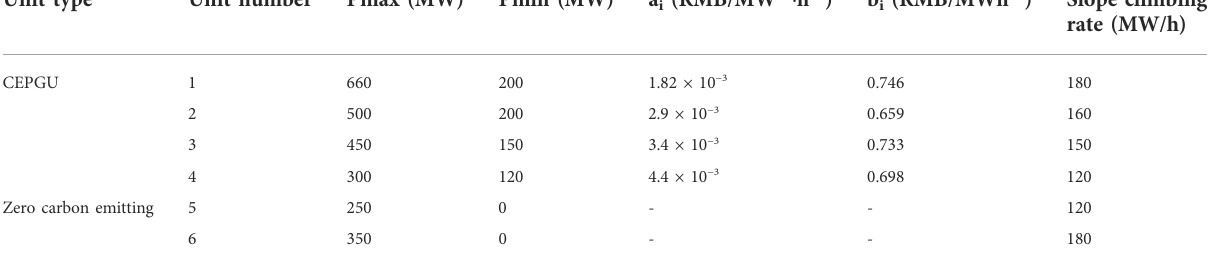
TABLE 1 Unit economic and technical parameters.